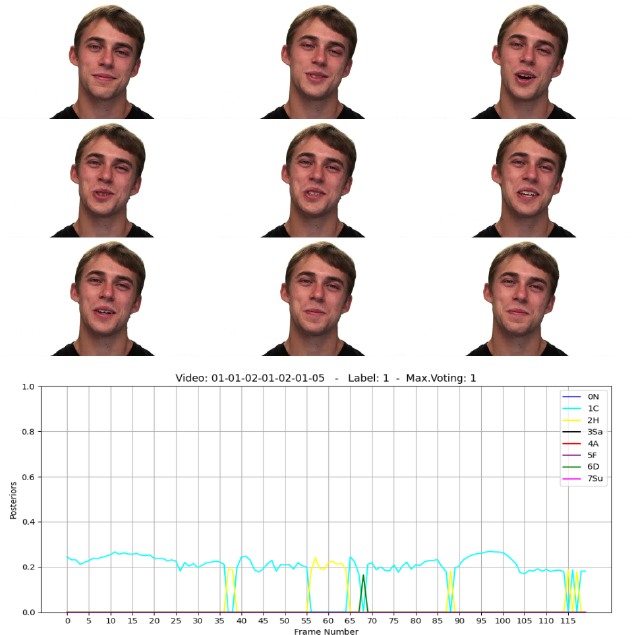
Figure A1. Example of frames from a video tagged as ‘Calm’ with some samples predicted as ‘Happy’. The whole video was correctly predicted as ‘Calm’.